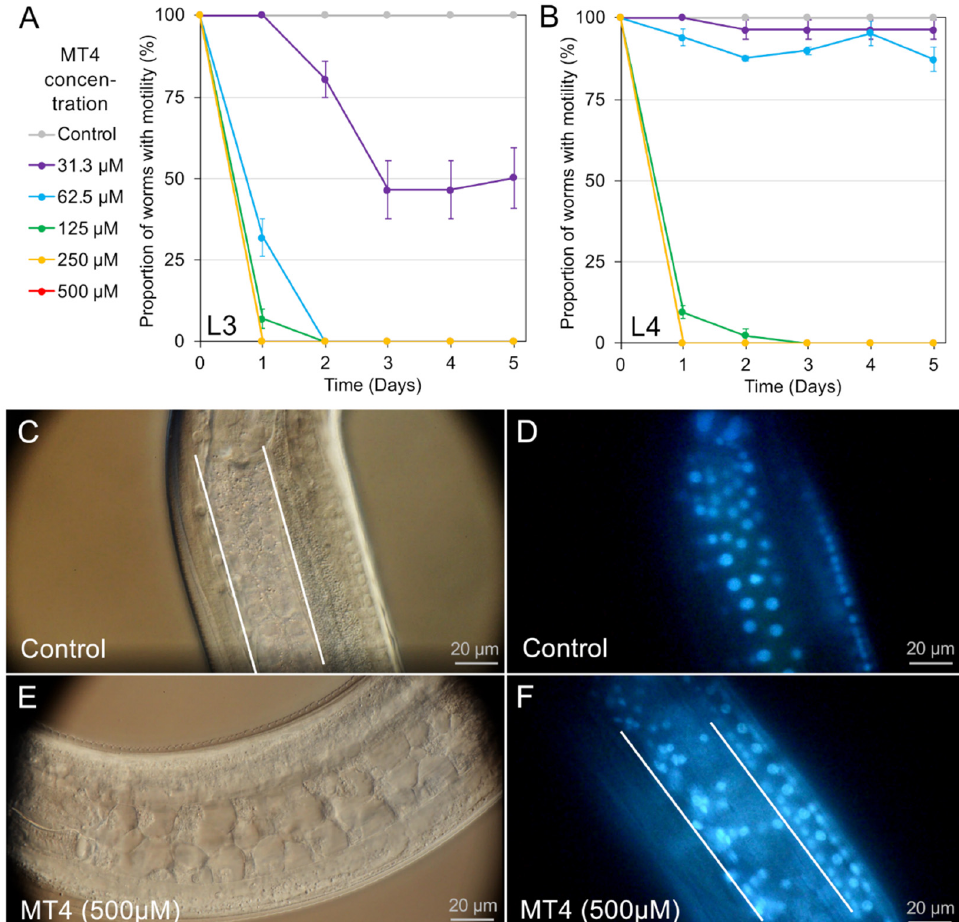
Figure 2. MT4 treatment on A. suum larvae. Motility assay results are shown for ( A ) L3-stage larvae (IC 50 55.5 µM at 24 h) and ( B ) L4-stage larvae (IC 50 91.4 µM at 24 h). ( C ) 2-day untreated control L3 larvae viewed with 60× differential interference contrast (DIC) microscopy (left) shows intact intestinal cells and ( D ) BB nuclear-staining shows a normal pattern of intestinal nuclei. Treatment with MT4 (500 µM) for 2 days induces ( E ) visible destruction of intestinal cells and ( F ) disrupted patterning of intestinal nuclei.